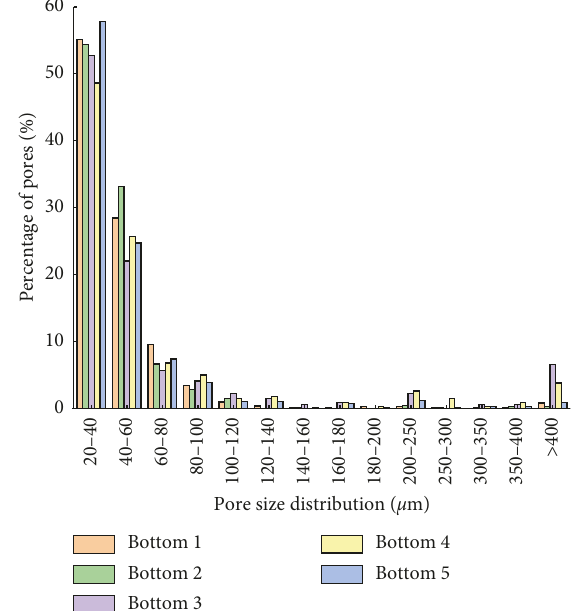
Figure 6: Pore size distribution of the aerated concrete block